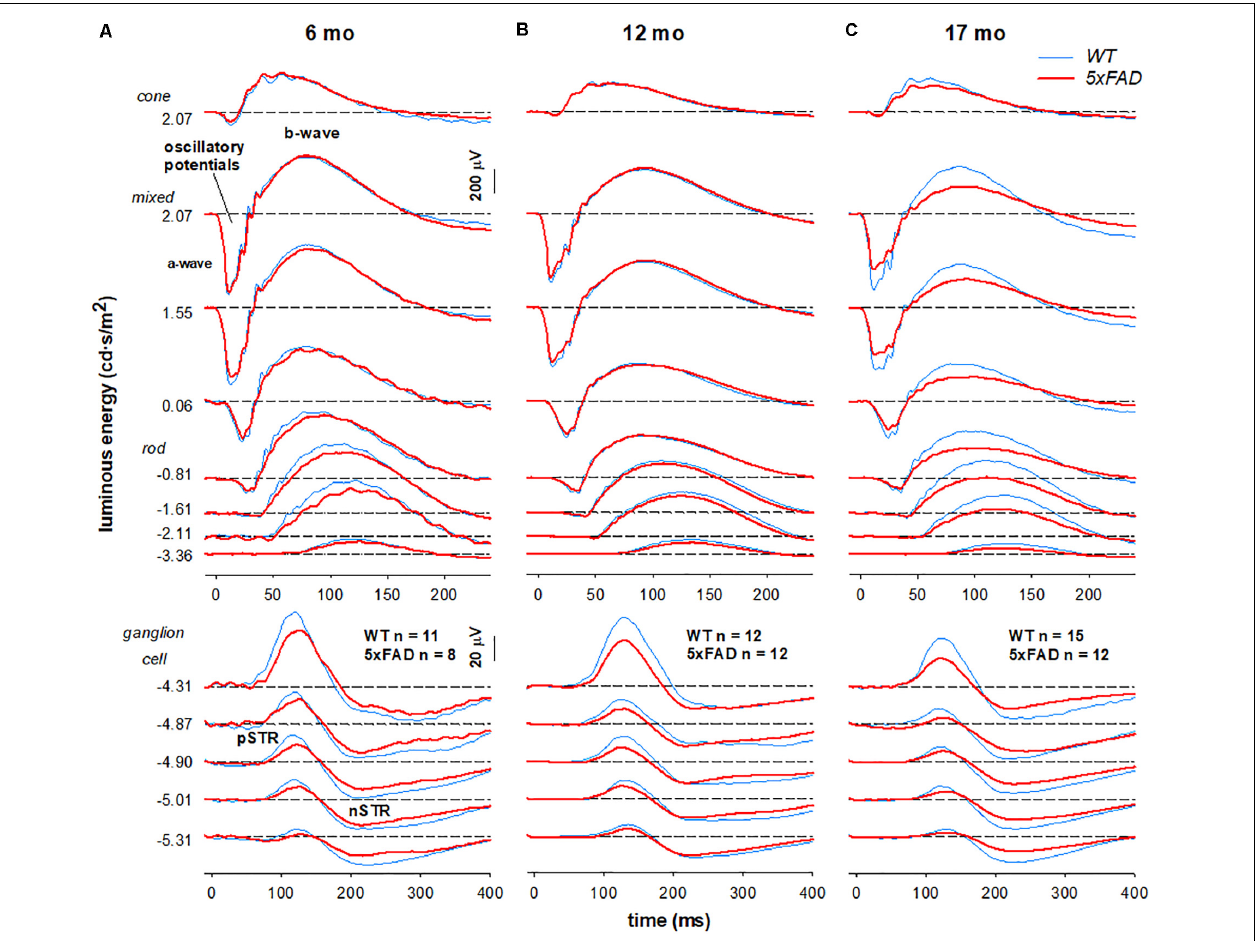
FIGURE 5 | Age-related changes in retinal function in 5xFAD mice. Grouped averaged waveforms are shown for (A) 6-month-old (B) 12-month-old (C) 17-month-old mice. Lower panels show the ganglion cell dominated STR response ( − 5.01 to − 4.87 log cd · s/m 2 ). Rod and mixed rod-cone response are elicited with increasing luminous energies. The uppermost panel reflects the cone response isolated using a twin-flash paradigm. STR, scotopic threshold response – ganglion cell dominant; pSTR, positive STR; nSTR, negative STR; a-wave – photoreceptoral response; b-wave – bipolar cell response; oscillatory potentials – amacrine cell